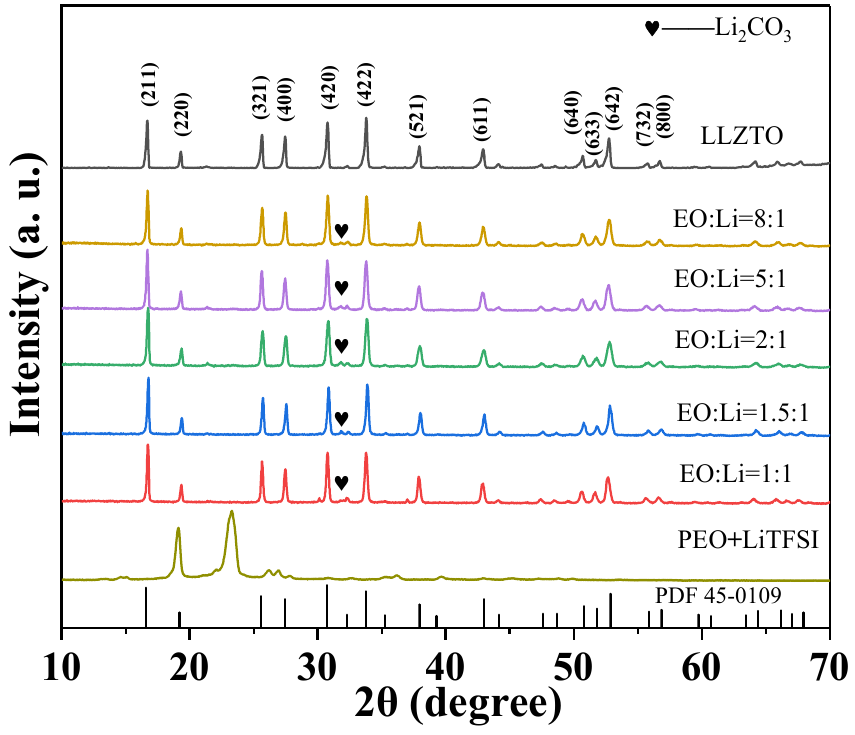
Figure 3. XRD patterns of different EO to Li molar ratios for cold-sintered LLZTO composite elec- trolytes.